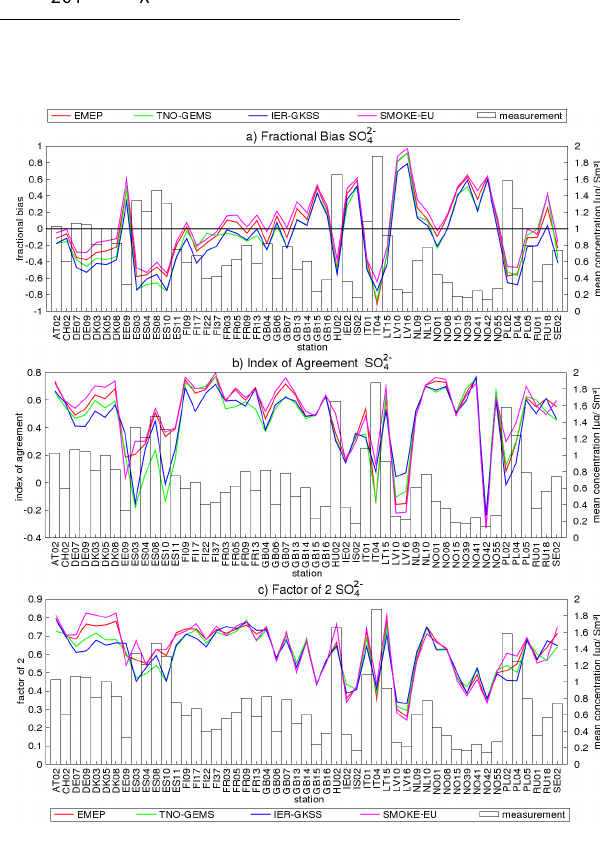
Fig. 14. Comparison of modelled SO 2 − concentrations using four 4 different emission datasets with daily mean observations from 51 rural EMEP measurement sites ( N = 17536) for the year 2000 (see also Tables 6 and 7). (a) Fractional bias (b) index of agreement (c) relative amount of values within a factor of 2 (1 =